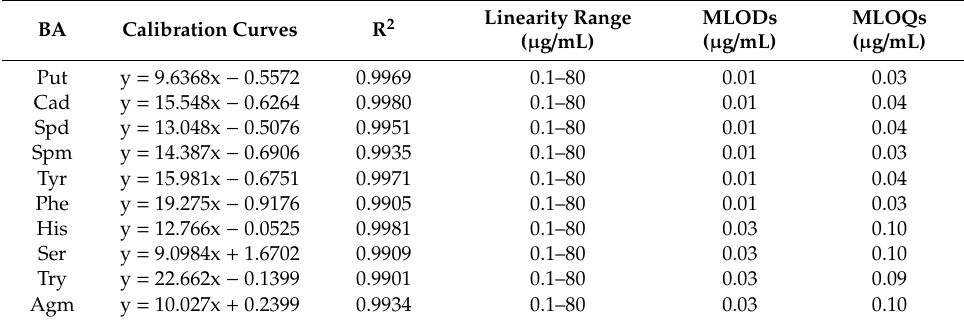
Table 2. Linear ranges, calibration curves, correlation coefficient (R), method limits of detection and quantitation (MLODs and MLOQs) of ten BAs.